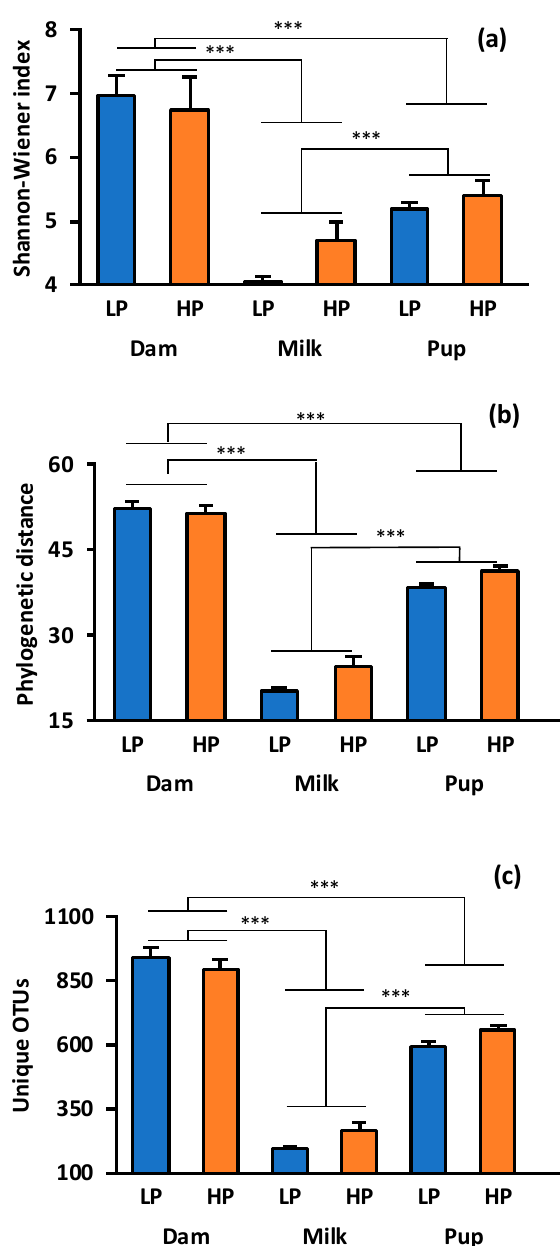
Figure 1. Comparison of bacterial OTUs (operational taxonomic units) for the milk and cecum of rats, consuming a 10% protein (low-protein (LP), blue bars) vs. 20% protein (high-protein diet (HP), orange bars) diet, and their pups. ( a ) Alpha diversity by location and diet using the Shannon–Wiener Index. ( b ) Alpha diversity by sample type and diet using phylogenetic distance. ( c ) Alpha diversity by location and diet using unique OTUs. Bar graphs show means and standard error bars. An asterisk indicates statistical difference (General linear models (GLM), *** p ≤ 0.0001).